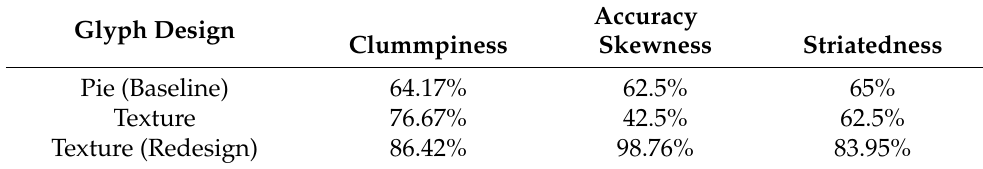
Table 3. Users’ performance.